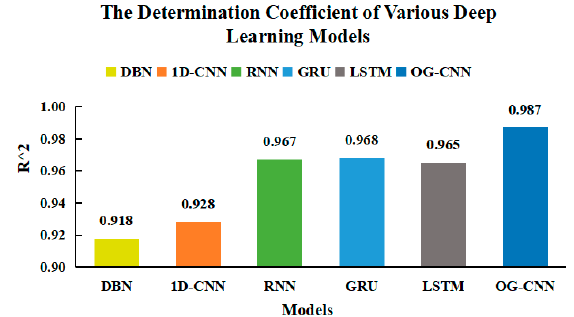
Figure 17. MRA of the results for various deep learning models.